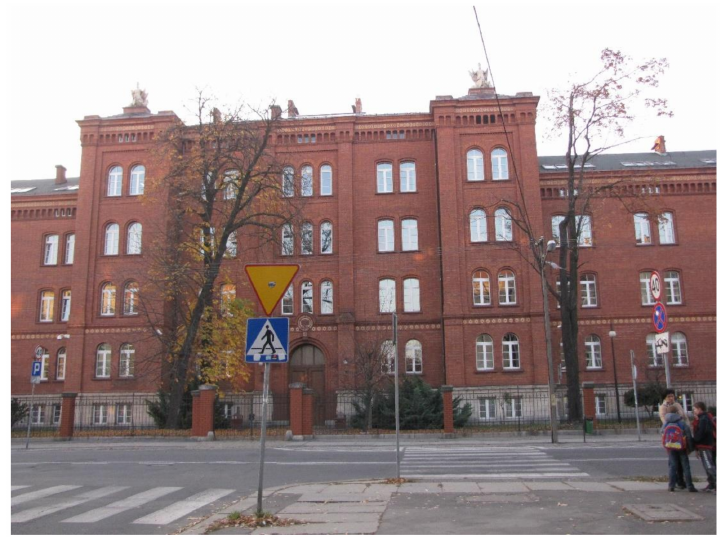
Figure 6. A contemporary view of the avant-corpse entrance to the main building in the Grenadier barracks—view corresponding to Figure 4 (photo by M.